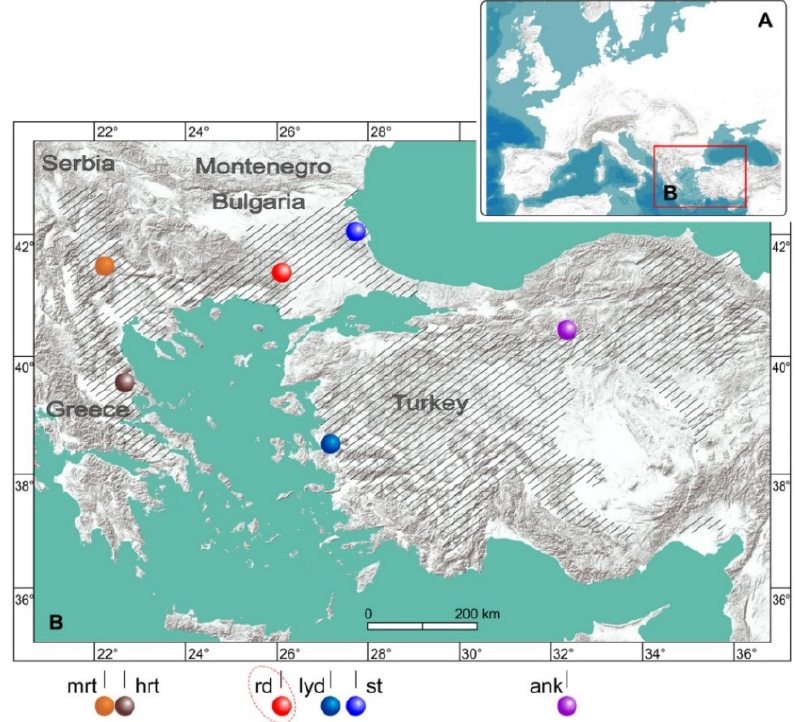
Figure 1. Distributional range of Harting’s social vole Microtus hartingi . The basis of the map is according to [10]. A: Part of Europe; B: Balkan and East Turkey. Colored circles mark the type of locality subspecies and M. hartingi from the Eastern Rhodopes. Abbreviations: brown dot, mrt, M. h. martinoi ; gray dot, hrt, M. h. hartingi ; red dot, rd, M. hartingi from the Eastern Rhodopes; green dot, lyd, M. h. lydius; blue dot, st, M. h. strandzensis ; violet, ank, M. h. ankaraensis .